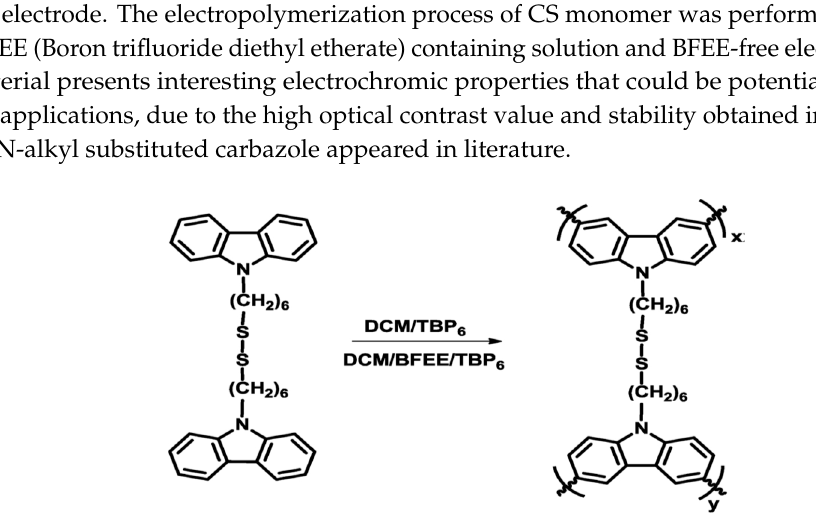
Figure 14. The synthesis of CK-CMP proposed by Yang et al. in their work. Reproduced with permission from [144]. Copyright (2019) Elsevier. L: 1,3,6,8-tetrakis(4-(9H-carbazol-9-yl) phenyl)pyrene, CK-CMP: conjugated microporous polycarbazole derivative.